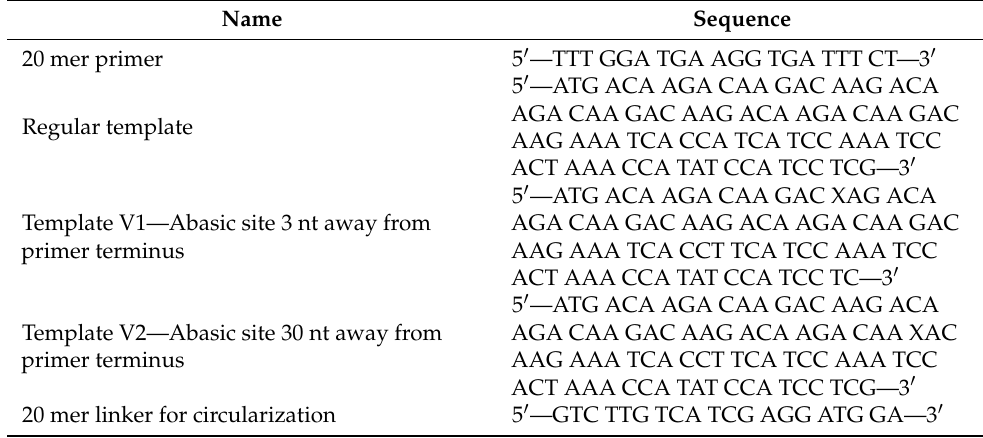
Table 1. List of DNA oligomers used in the